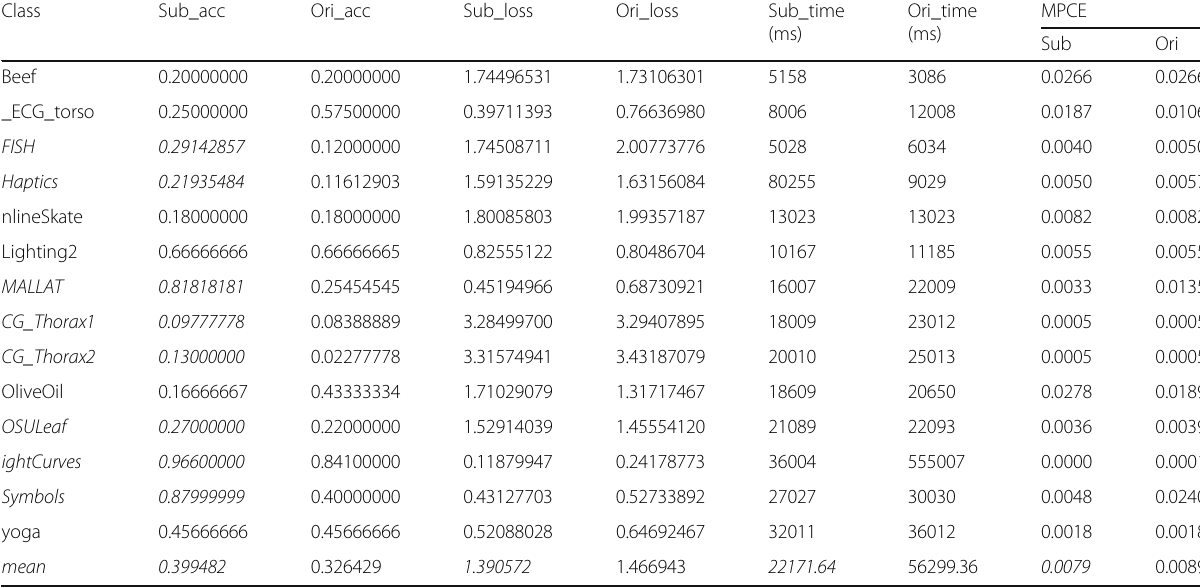
Table 3 Comparison of loss, accuracy, and time of OTS and characteristic subsequences on